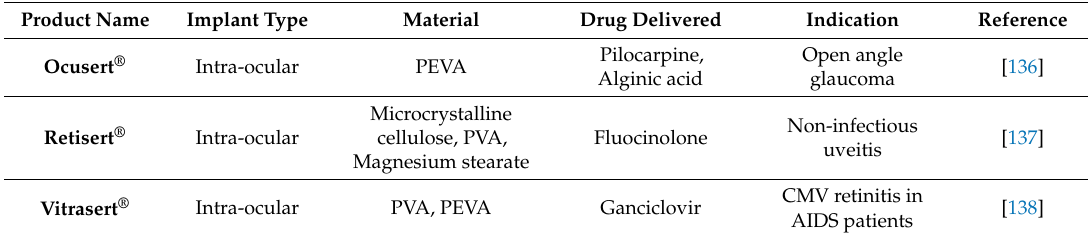
Table 3. Examples of implantable drug delivery devices used to treat ocular diseases.